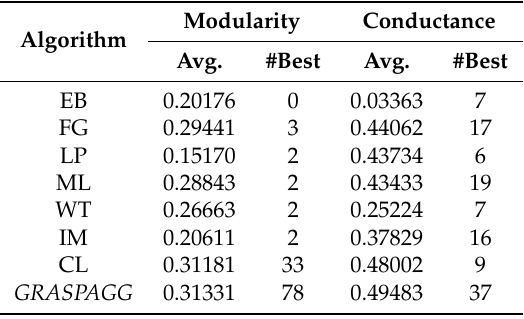
Table 4. Comparison of the considered metrics over all the algorithms presented in Section 3 and the proposed GRASPAGG method. Algorithm